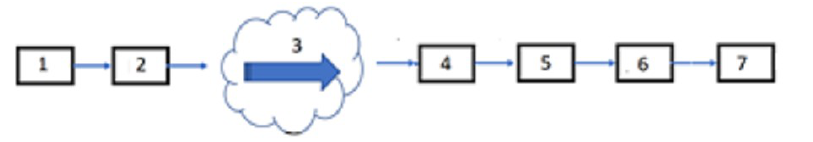
Fig. 6. Functional diagram of the information-measuring system: 1 – hydroacoustic setup with